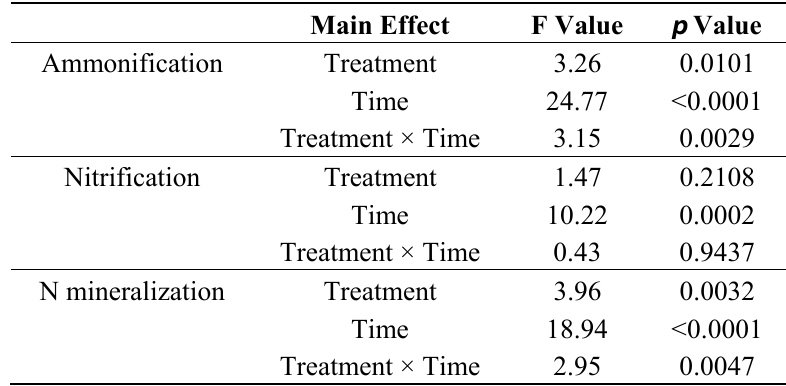
Table 4. Table of F-statistics and p -values for ANOVAs of ammonification, nitrification, and N mineralization for treatment, time, and treatment × time. All PyC type and concentrations fall under